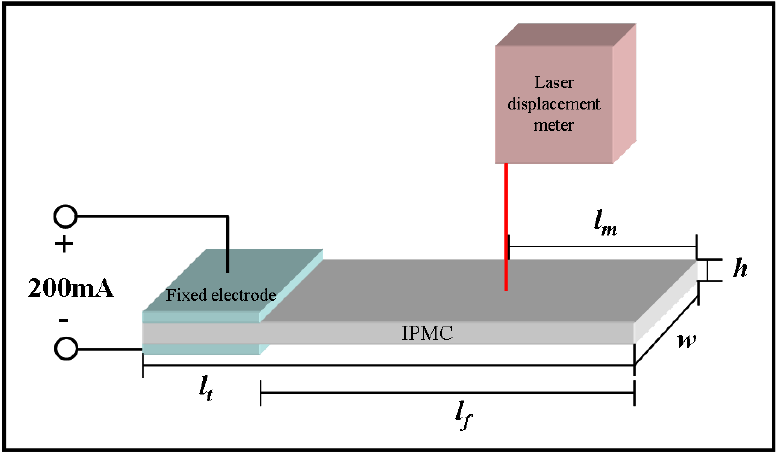
Figure 1. Schematic diagram of IPMC and IPMZC deflection measurement location ( l : 5 cm, l : 4 cm, w : 1 cm, h : 0.02 cm, and l t f